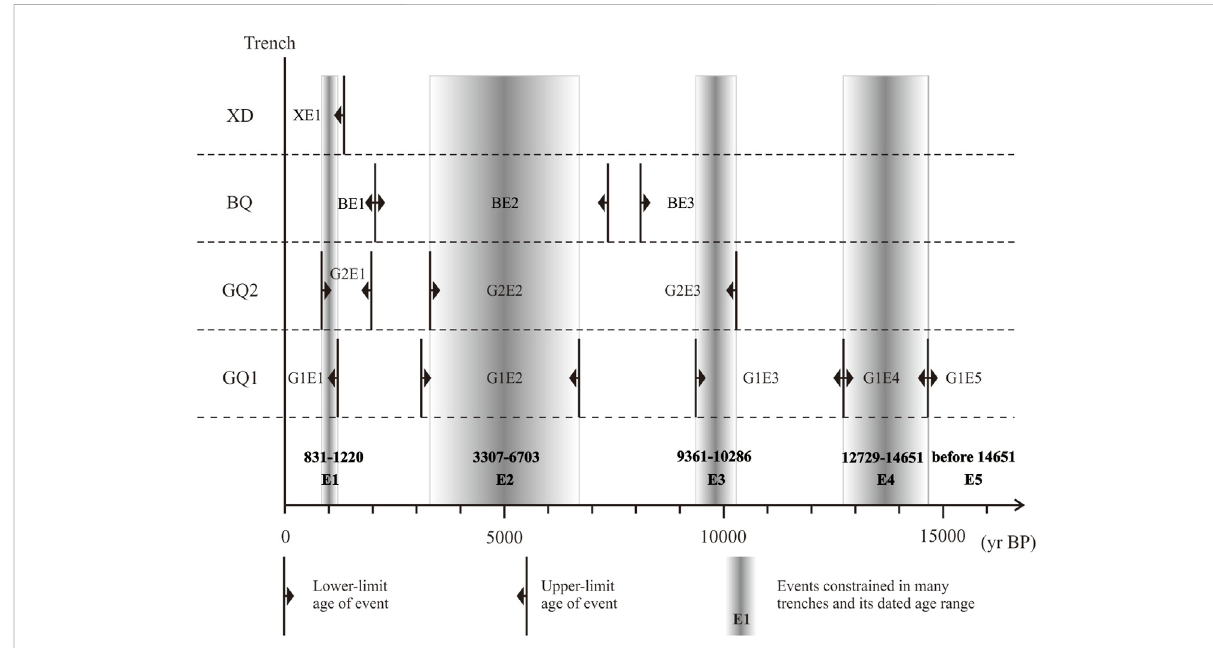
FIGURE 15 Constraints of the paleoseismic events and ages from the three trenches (GQ1, GQ2, and BQ) and one exposure